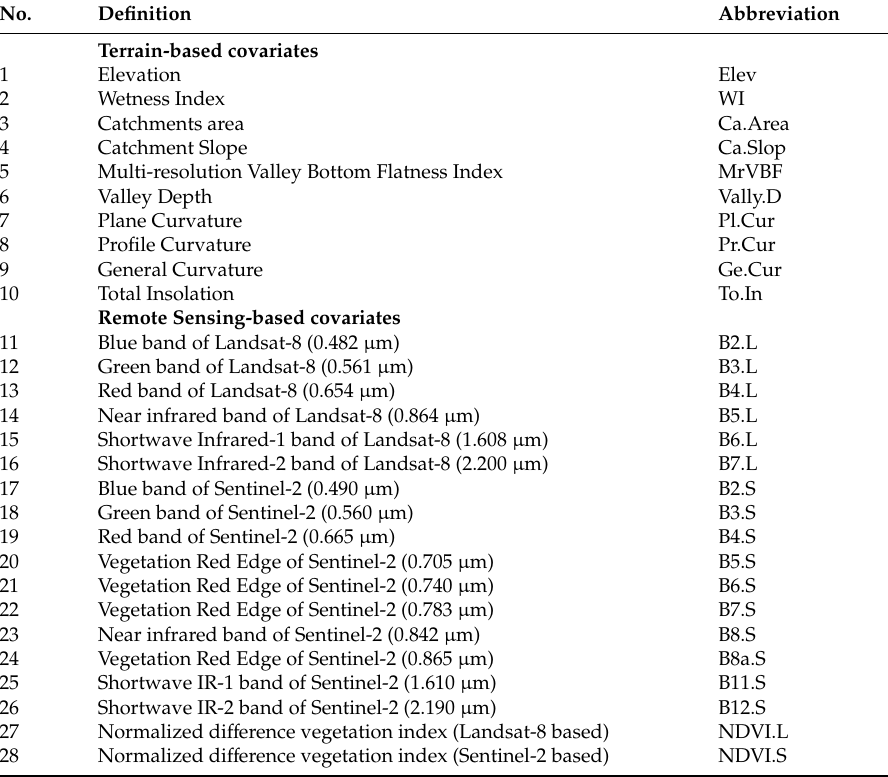
Table 2. Covariates used for the development of machine learning (ML)